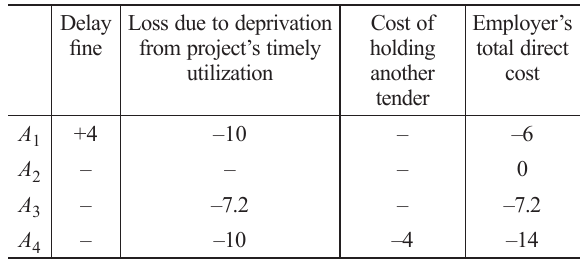
Table 4.A. Elements consisting employer’s costs for different alternatives (in million$)